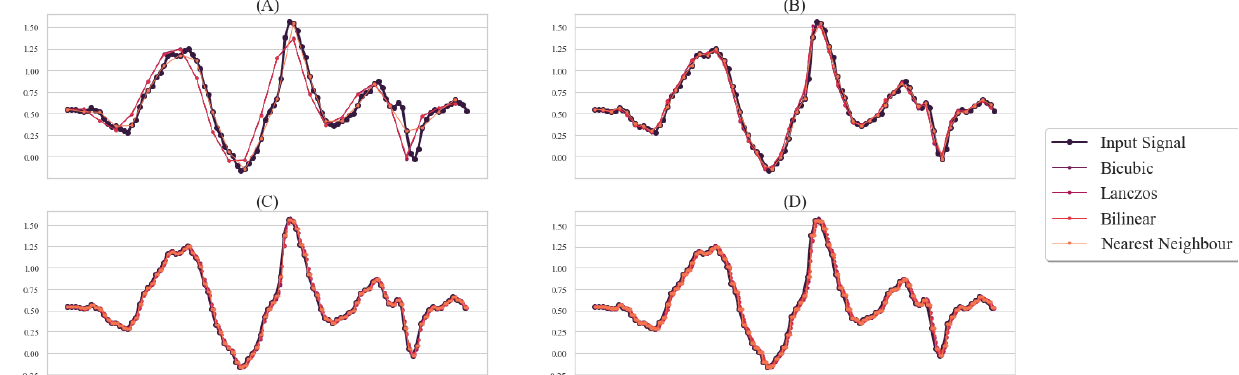
Figure 1. Different interpolation techniques applied on time-series data for upsampling and downsampling. ( A ) for 1/4 downsampling (signal length from 100 to 25), ( B ) for 1/2 downsampling (signal length from 100 to 50), ( C ) for 2 × upsampling (signal length from 100 to 200), ( D ) for 4 × upsampling (signal length from 100 to 400). The input signal was taken from the smart-band